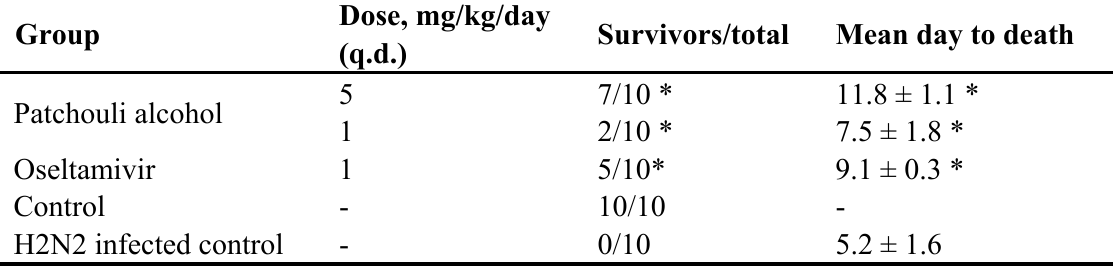
Table 2. Comparison of efficacy of patchouli alcohol with oseltamivir in the in vivo mouse influenza model (oral treatment).